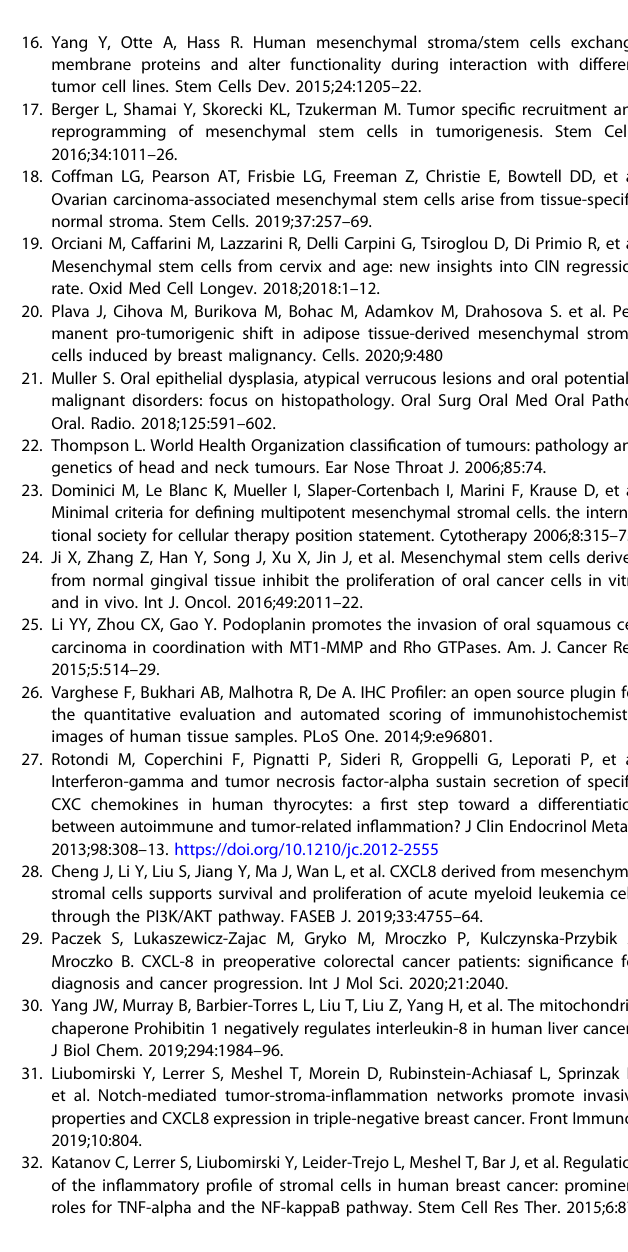
Fig. 7 Schematic depiction. CPNE7 controls CXCL8 secretion through the NF- κ B signalling pathway, promoting the metastasis of OSCC cells in the malignant transformation of OLK to